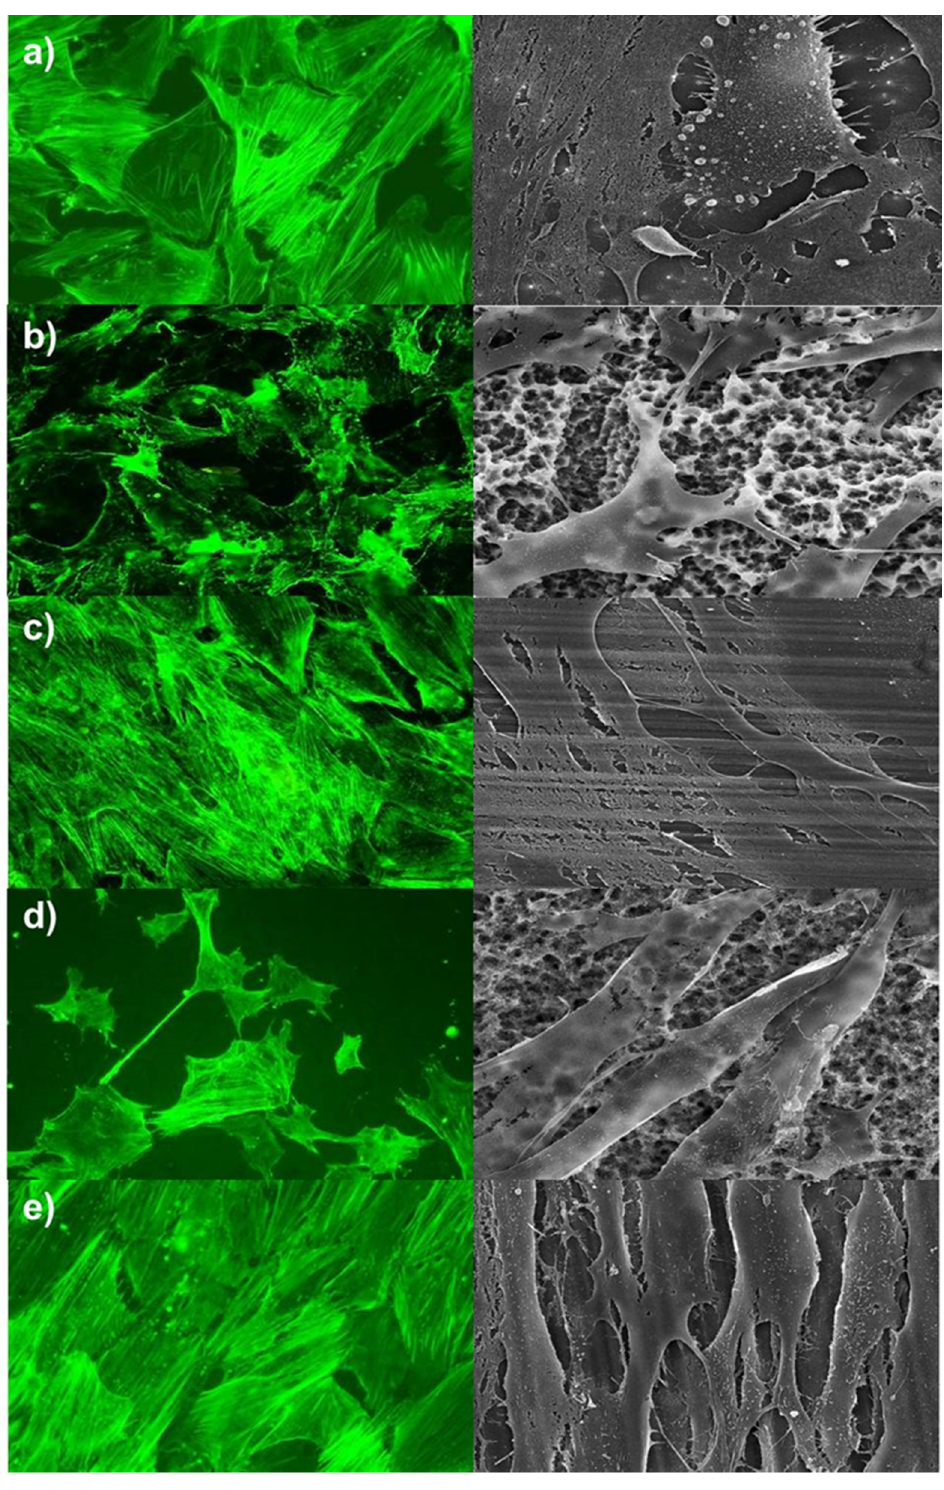
Figure 1. Alterations in the cell morphology of human adipose-derived stromal cells (hADSCs). Left site = f-actin staining, magnification factor ×100; right site = SEM, magnification factor ×1200. ( a ) Control, ( b ) rough titanium (Titan-SLA), ( c ) titanium with a smooth surface texture (Titan-PT), ( d ) zirconia material (ZrO 2 -ZLA), and (e) machined zirconia (ZrO 2 -M).